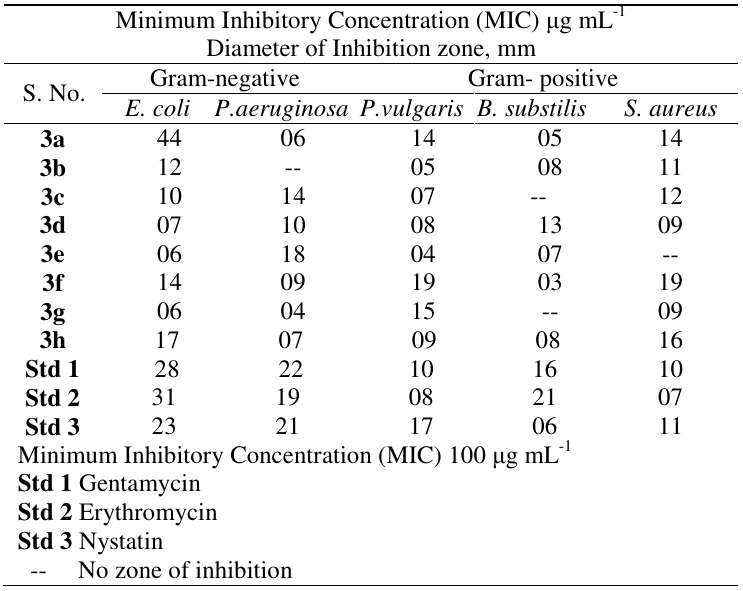
Table 3. Antibacterial activity of compounds